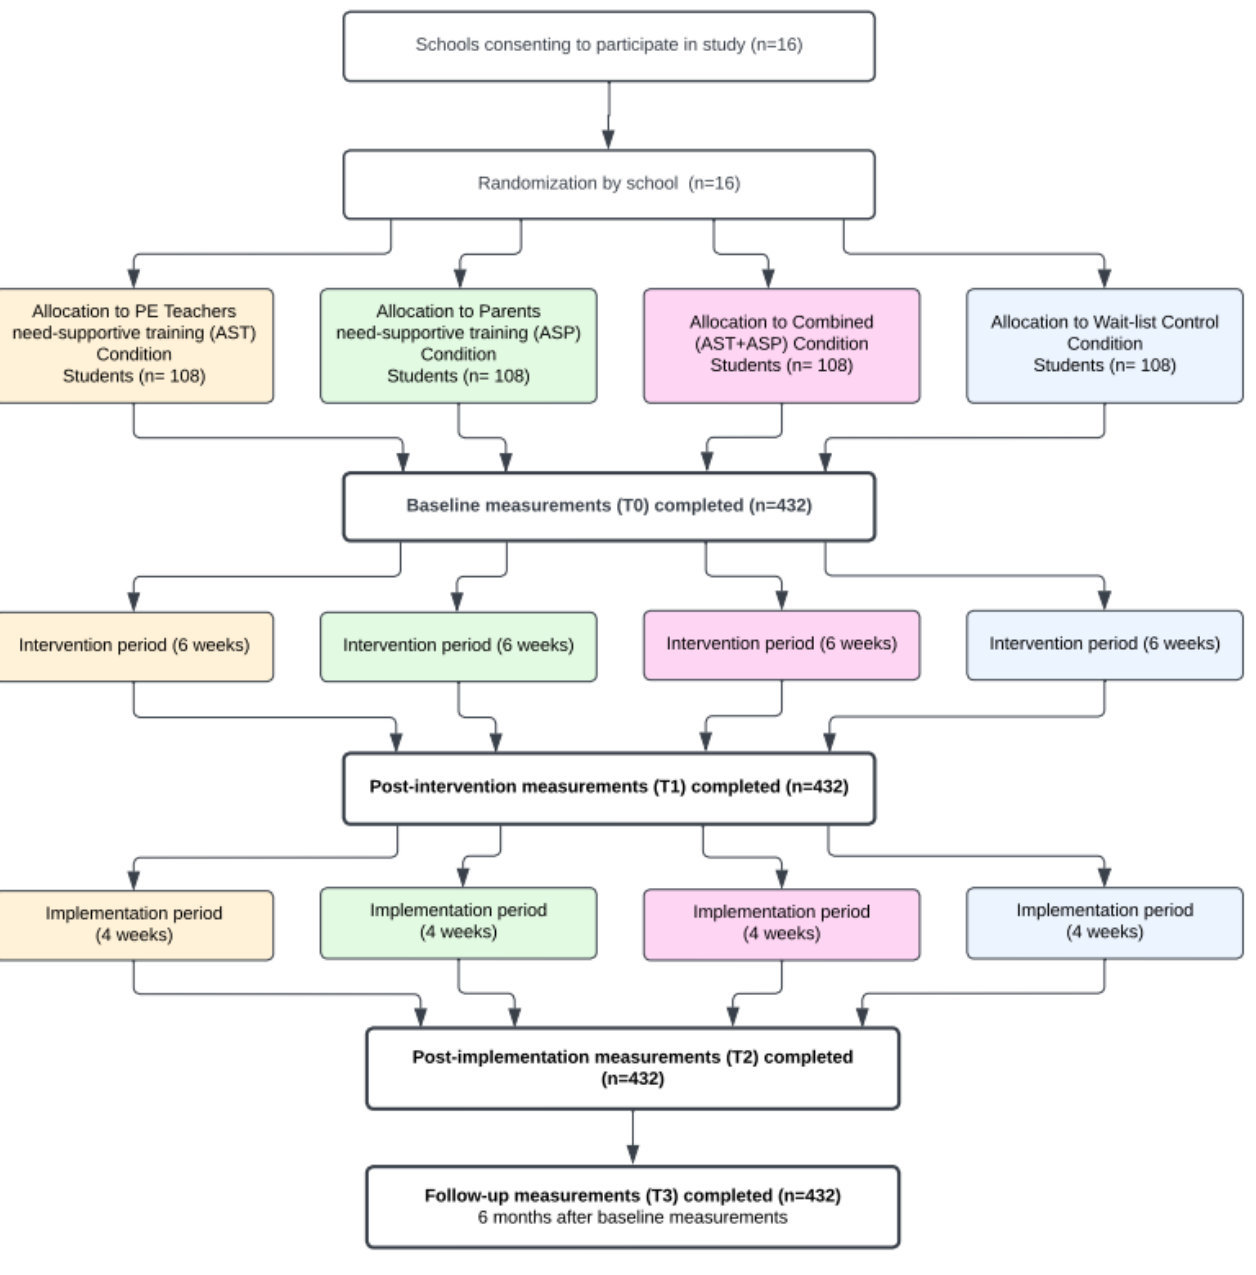
Figure 2. Participant flow diagram.